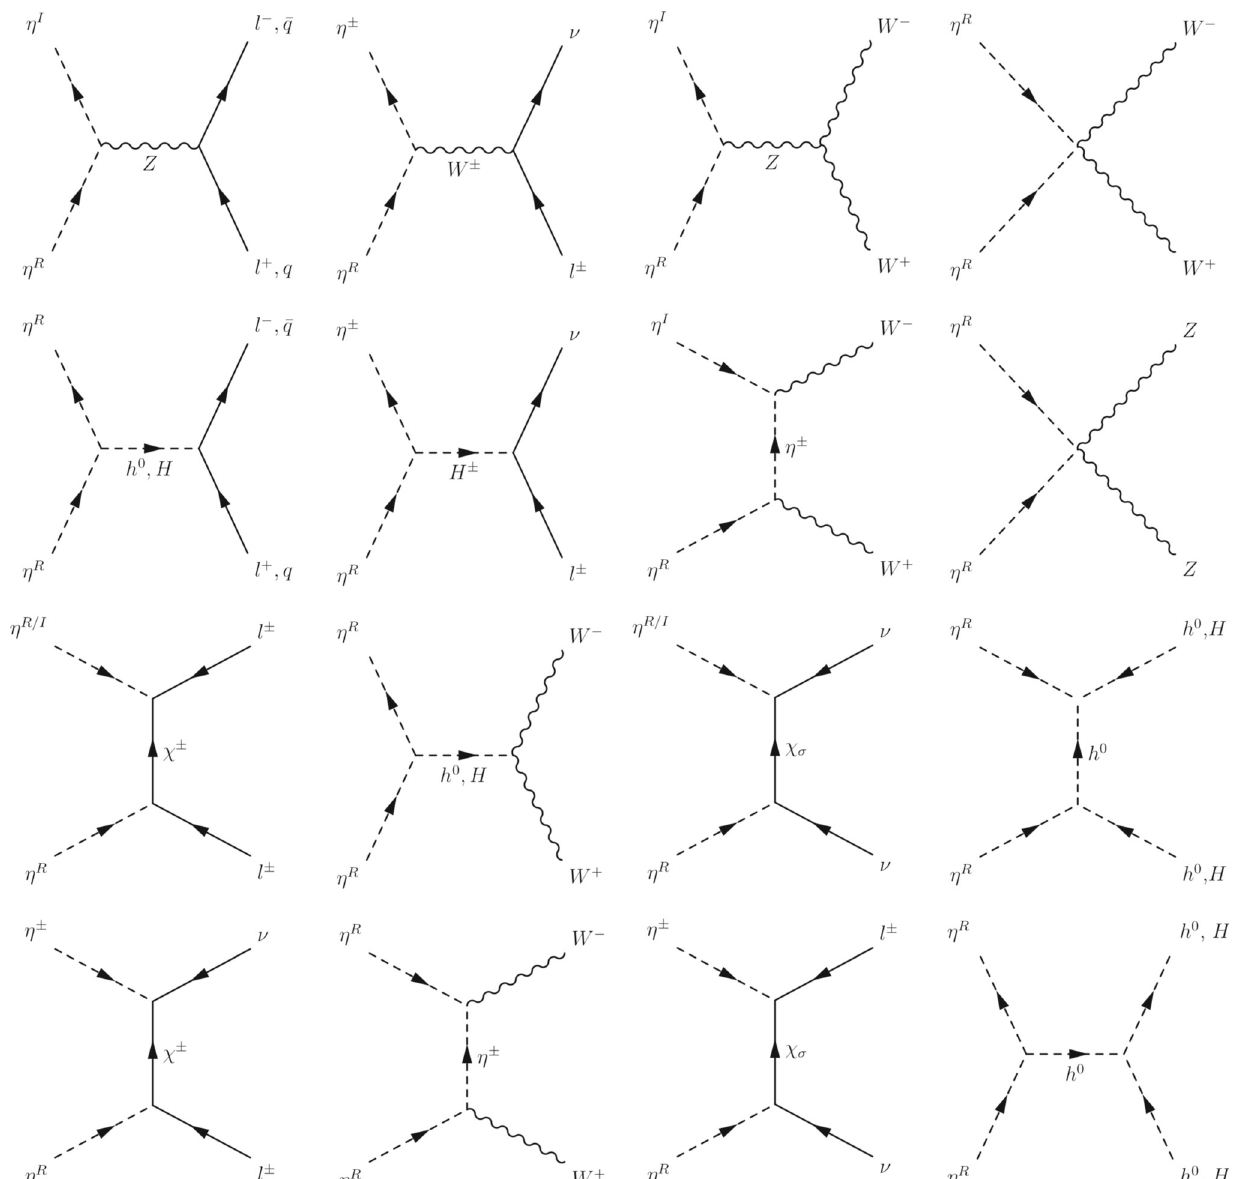
Fig. 11 Relevant annihilation and coannihilation diagrams contributing to the relic abundance of η R